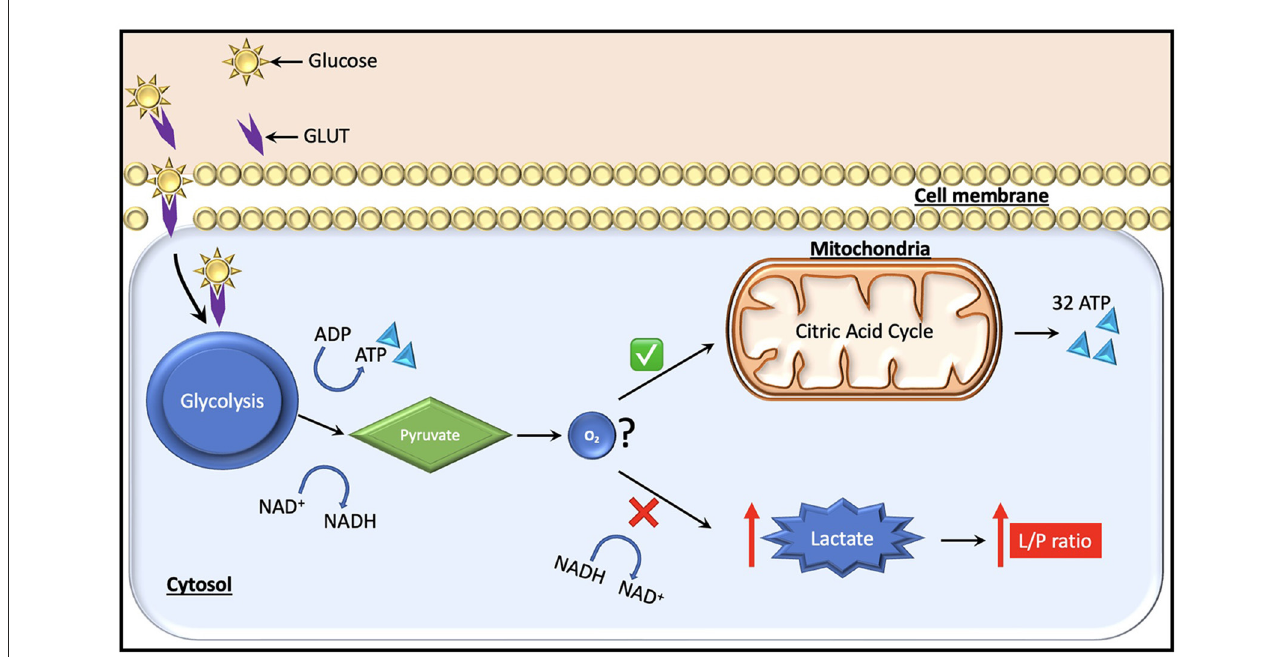
FIGURE2 Glucose, which is the major fuel in the brain, is transported across the cell membranes by facilitated diffusion mediated by glucose transporter proteins (GLUT). Two types of glucose transporters (sodium dependent and facilitative transporters) are localized in the membranes of neurons, astrocytes and brain endothelial cells. Of these, GLUT-1 and GLUT-3 represent the two most important transporters in the brain. Under normal conditions, pyruvate is formed from glucose after entering the glycolytic process generating two molecules of ATP. Subsequently, it enters the citric acid cycle if oxygen is available, yielding 32 ATP molecules. During a state of cerebral hypoxia and low glucose (e.g., intracranial hypertension) the production of ATP from the citric acid cycle decreases. Then, cells attempt to compensate for the decrease in ATP production by increasing the turnover of glucose in the anaerobic part of the glycolysis. During this process it is necessary to regenerate NAD + from NADH, which facilitates maintenance of glycolysis. The NAD + regeneration causes an increase in lactate and the lactate/pyruvate ratio. The ratio is essentially the same in all tissues (i.e., about 20). A ratio above 25 is considered as an early warning of beginning metabolic